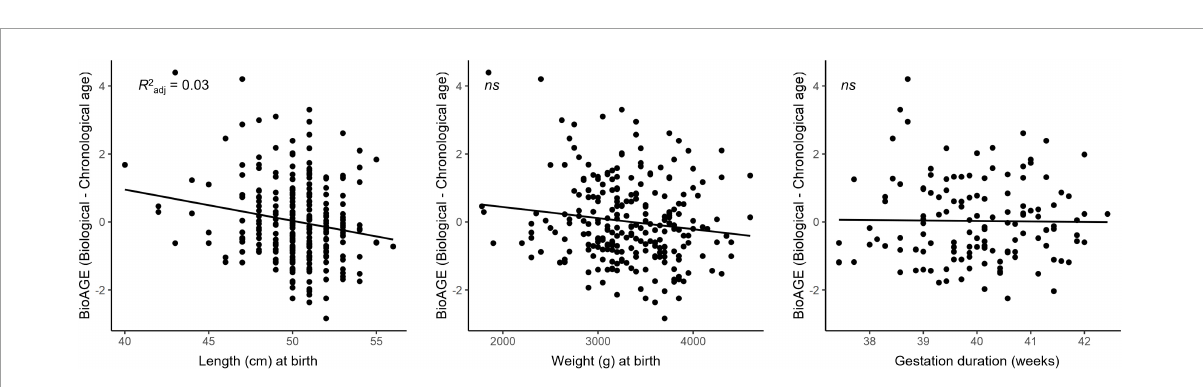
FIGURE4 Accelerated biological aging in the late 20s was predicted by birth length but not birth weight or duration of